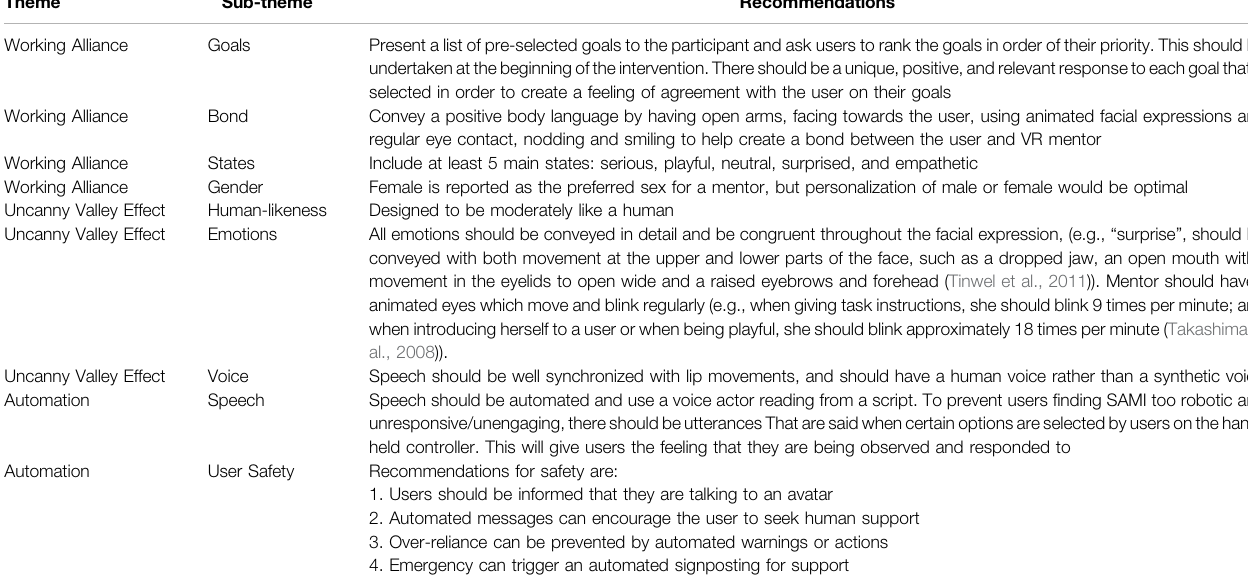
TABLE 2 | Semi-autonomous design considerations. Theme Sub-theme Recommendations Working